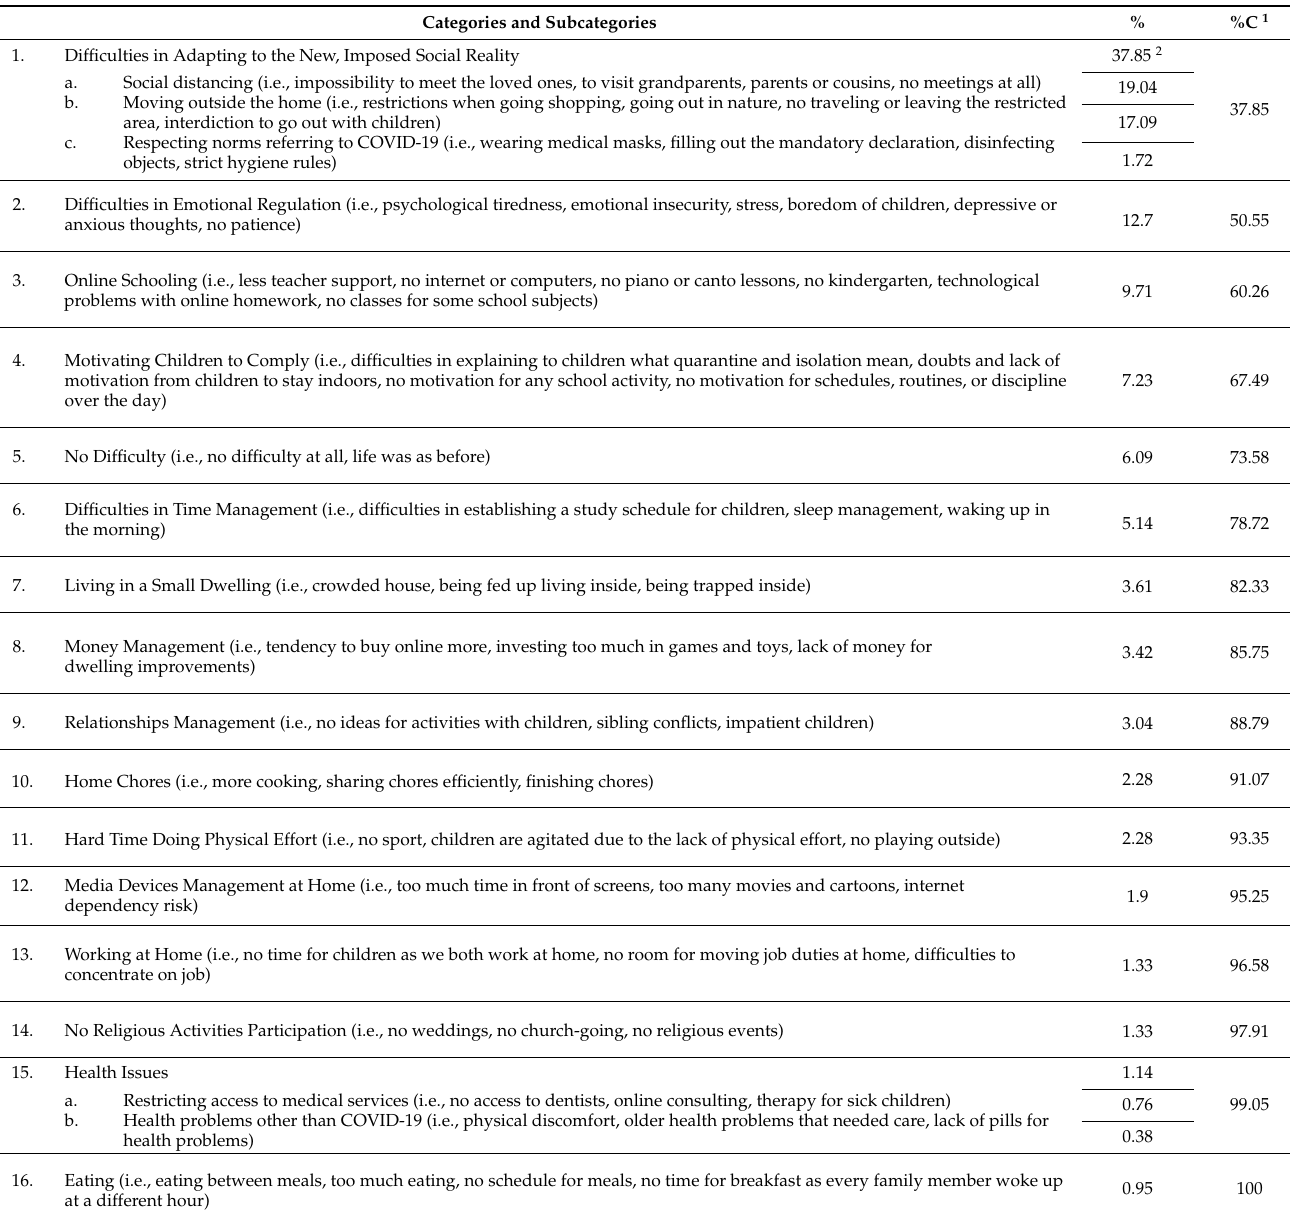
Table 2. The categories and subcategories of answers to the second research question of the qualitative study. Categories and